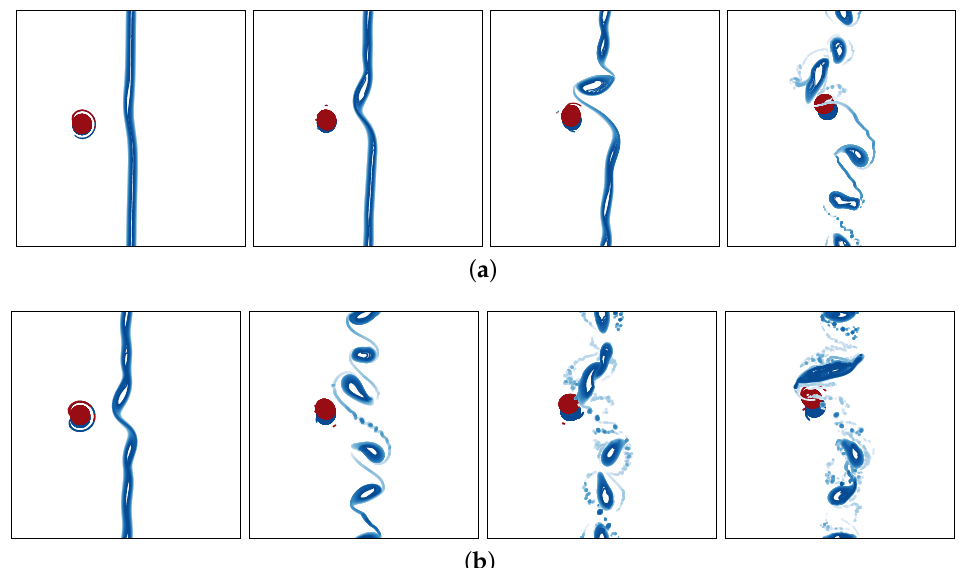
Figure 16. Cases 6.3 ( a ) and 6.4 ( b ): effect of halving the filament half-width a from 0.25 to 0.125. The dimensionless horizontal shear remains Λ = 0.4 in case 6.3 while it is increased by a factor of 2 in case 6.4, with all other parameters the same as in case 1. Top view of the flow showing contours of buoyancy and PV. In ( a ), the times shown are t = 16, 26, 34 and 50, while in ( b ), the times shown are t = 16, 23, 28 and